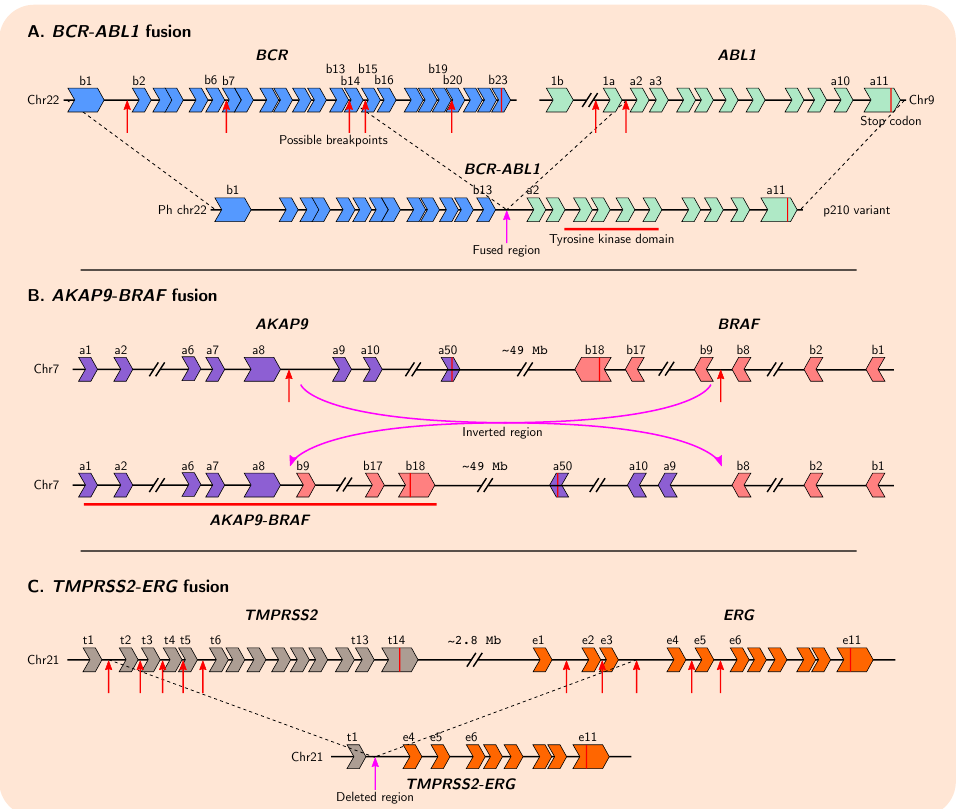
Figure 3. Snapshots of exon arrangements in well-known gene fusions in cancer. ( A ) Reciprocal translocation between different breakpoints within introns of BCR and ABL1 can give rise to different fusion gene variants. ( B ) Chromosomal inversion between specific introns of AKAP9 and BRAF results in fusion gene formation. ( C ) Breakage at multiple possible loci in TMPRSS2 and ERG with subsequent interstitial deletion results in fusion of the two genes. Many fusion products are possible. Illustrations are simplified and are not to scale. Red arrows indicate breakpoints that have been previously experimentally